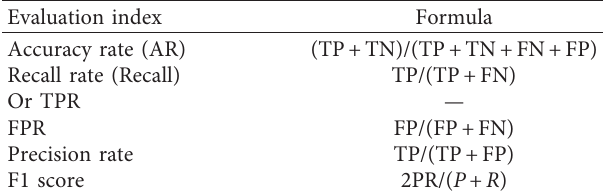
Table 4: AUC evaluation ability classification.